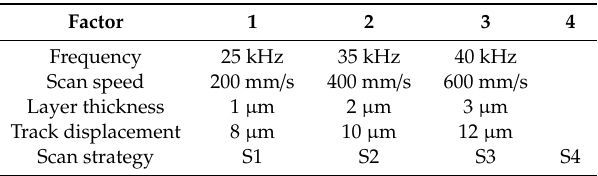
Table 1. Factors and their respective